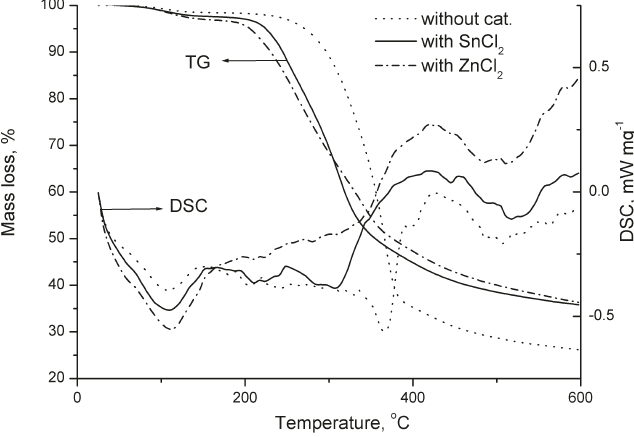
Figure 4. Thermograms of pyrolysis of spruce wood with SnCl